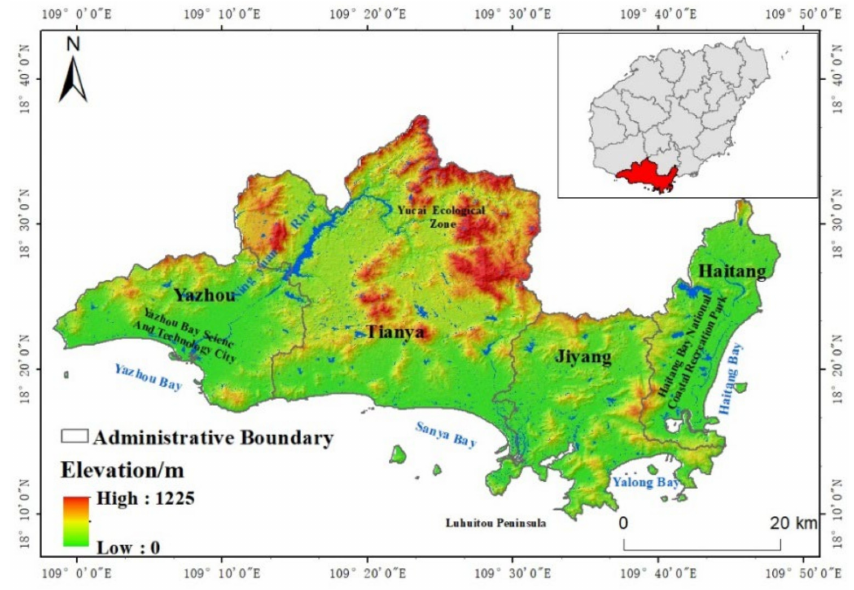
Figure 1. Location of Sanya